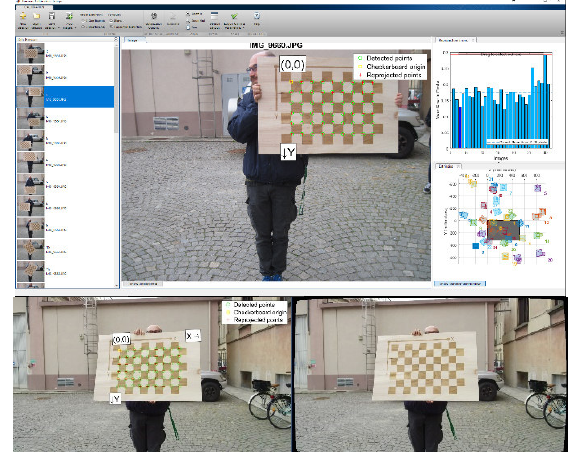
Figure 7. Example of the acquired images (Huawei P9) and the camera calibrator